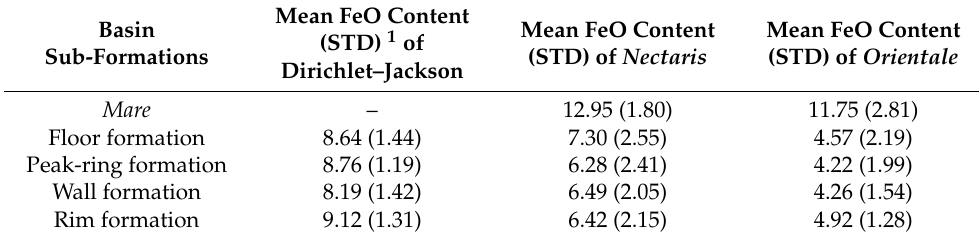
Table 1. Mean FeO contents in the sub-formations of the three basins. Basin Sub-For-